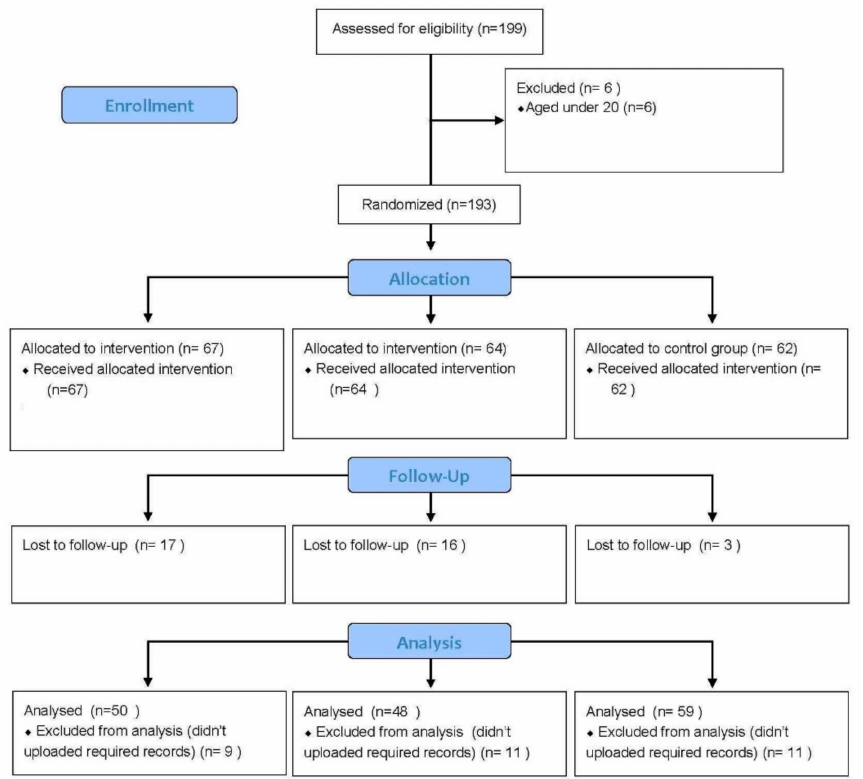
Figure 1. Flow chart of this